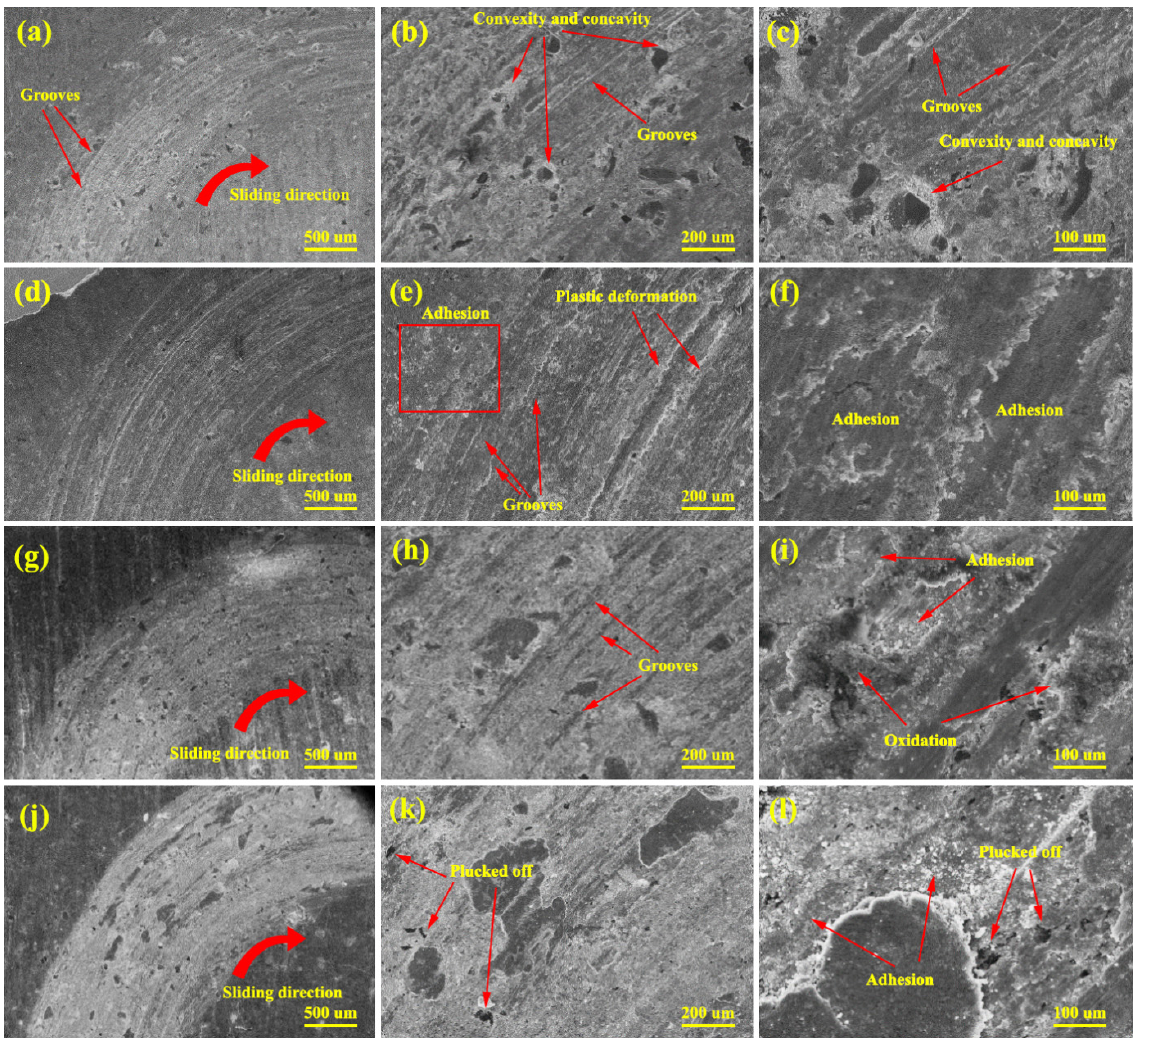
Figure 10. SEM micrographs of worn surface of: ( a – c ) sample 1, ( d – f ) sample 3, ( g – i ) sample 5, and ( j – l ) sample 6.